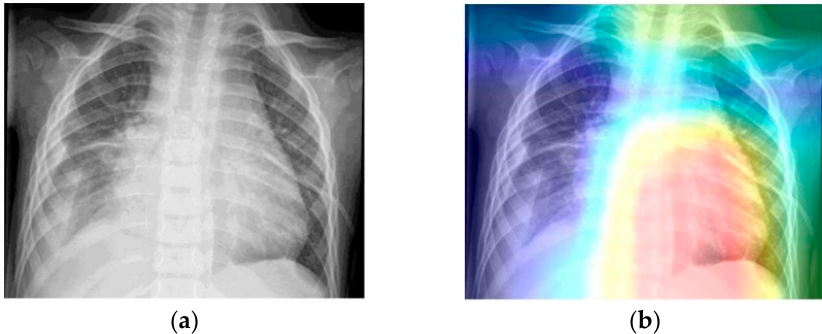
Figure 13. An example of LZnet2019 performance. ( a ) is an original CXRAY and ( b ) its corresponding Grad-CAM from the LZNet2019 article.